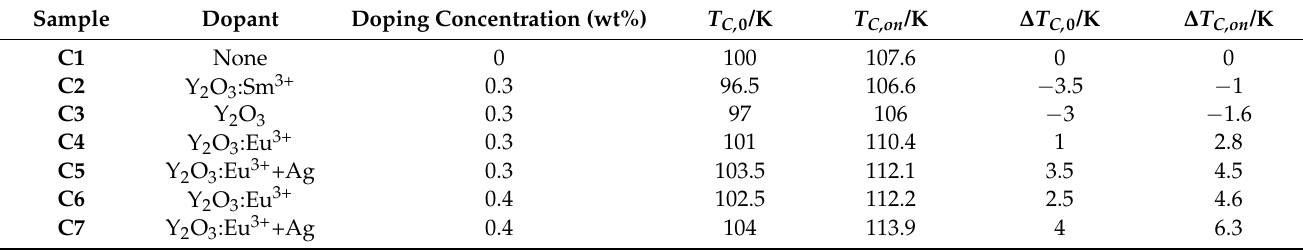
Table 3. Dopant, doping concentration, T C, 0 , and T C,on of C series samples prepared from raw material S3 (5 µ m).